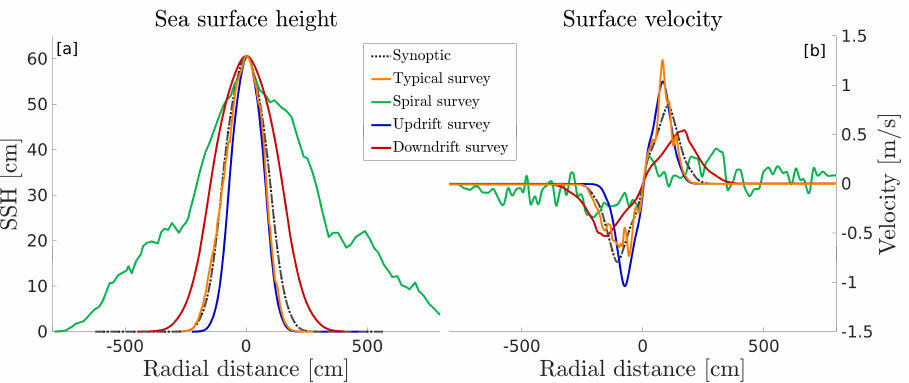
Figure 6. ( a ) Measured SSH profiles for the 4 tested synthetic survey strategies (continuous col- ored lines) and for the synoptic case (dashed gray line). ( b ) Same as panel (a) for the surface azimuthal